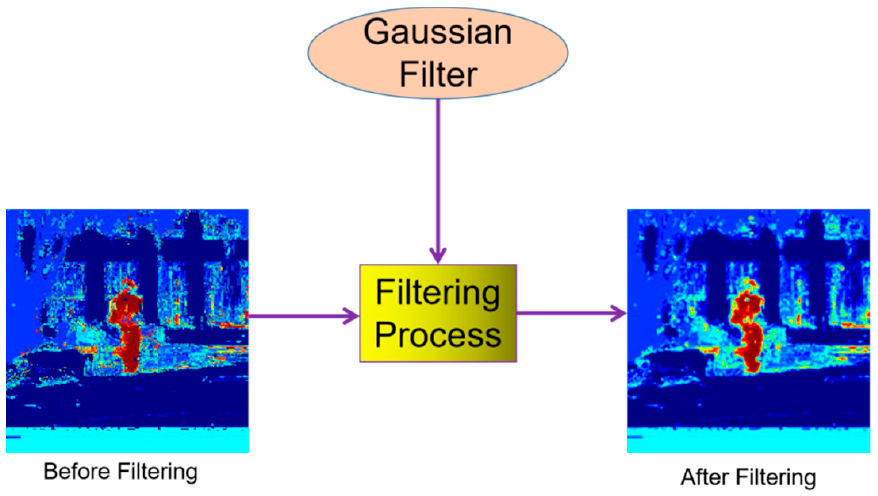
ff ect of processing original histogram-score map by Gaussian Figure 3. Effect of processing original histogram-score map by Gaussian filter. Figure 3. E